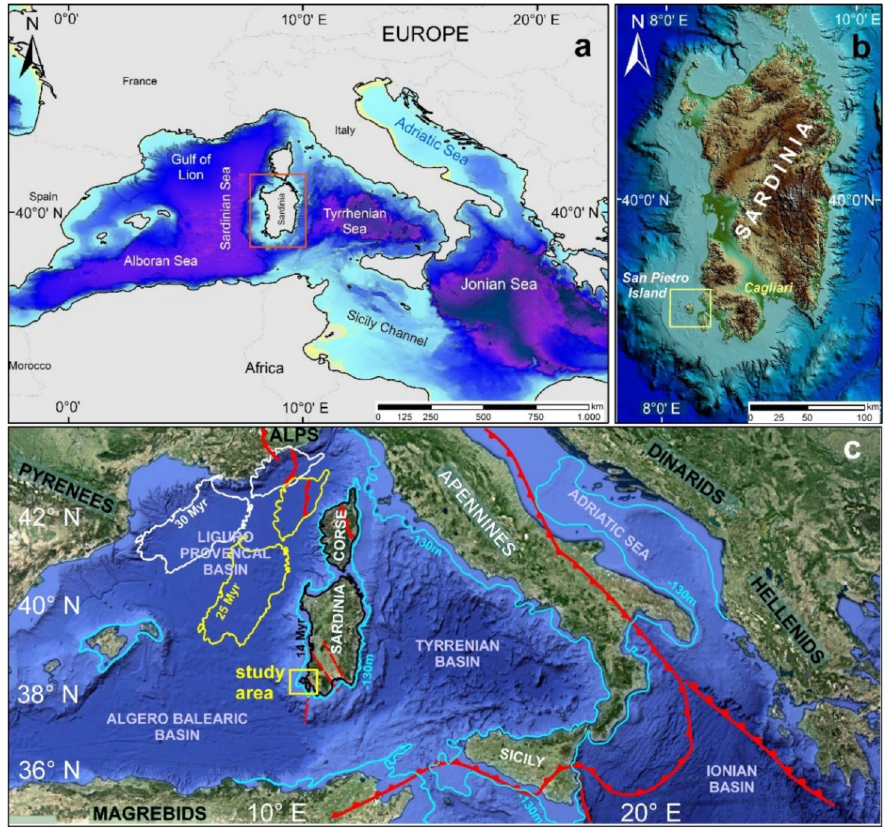
Figure 1. Geographic location and structural setting of the study area: ( a ) Sardinia Island within the Mediterranean Sea; ( b ) San Pietro Island on the SW side of Sardinia; ( c ) structural sketch map of the Mediterranean area. Red lines mark thrust fronts; white line the Sardinian-Corse block translation 30 Myr BP; yellow line Sardinian-Corse block translation 25 Myr BP (mod. after Carminati and Doglioni, 2008 [18]); Black line the Sardinian-Corse block translation 14 Myr (Gattacceca et al., 2007 [19]); Light blue color line, isobath of − 130 m represents the coastline during the Last Glacial Maximum